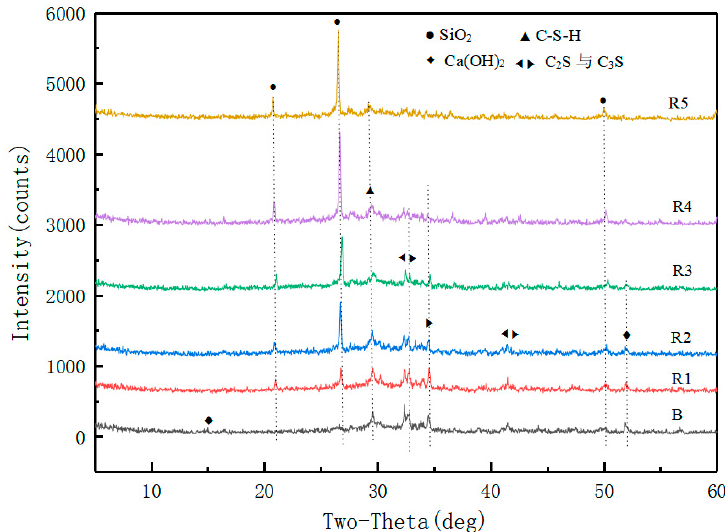
Figure 10. XRD analysis of each group of specimens.